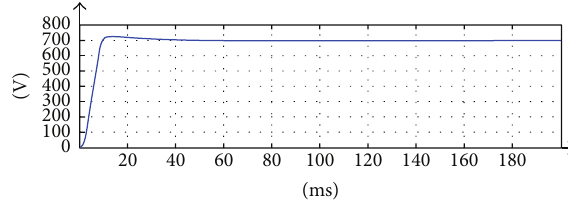
Figure 2: Dynamic response curve of DC bus voltage (nonload).